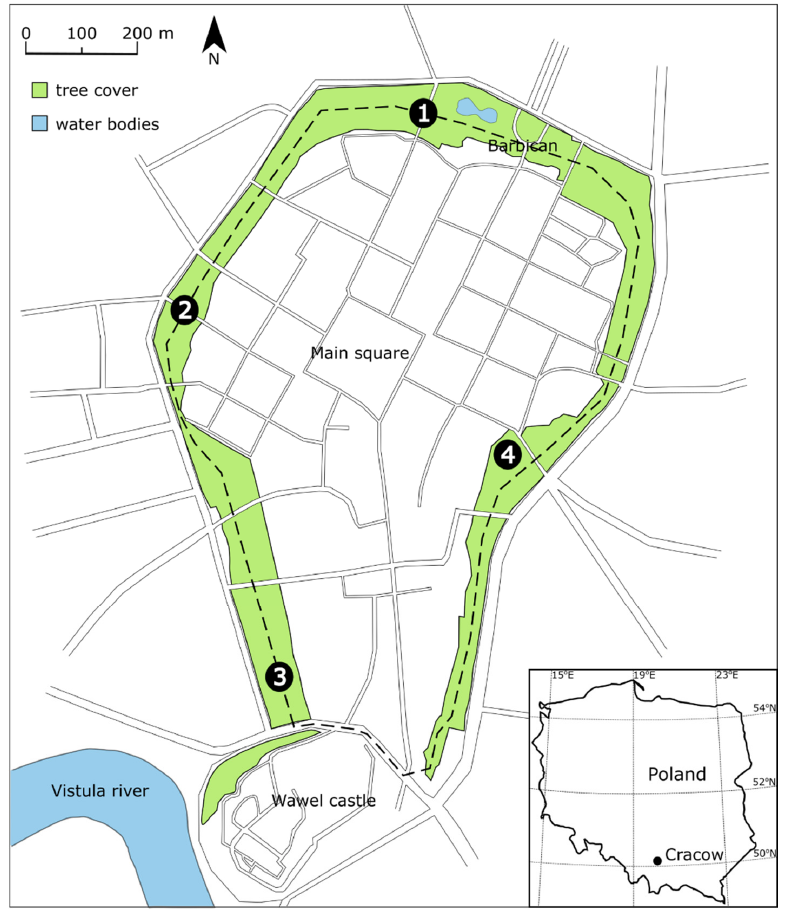
Figure 1. Planty Park in Cracow. The route followed by researchers during weekly recording sessions has been marked with a dashed line. Numbers refer to established checkpoints in which meteorological parameters were recorded.